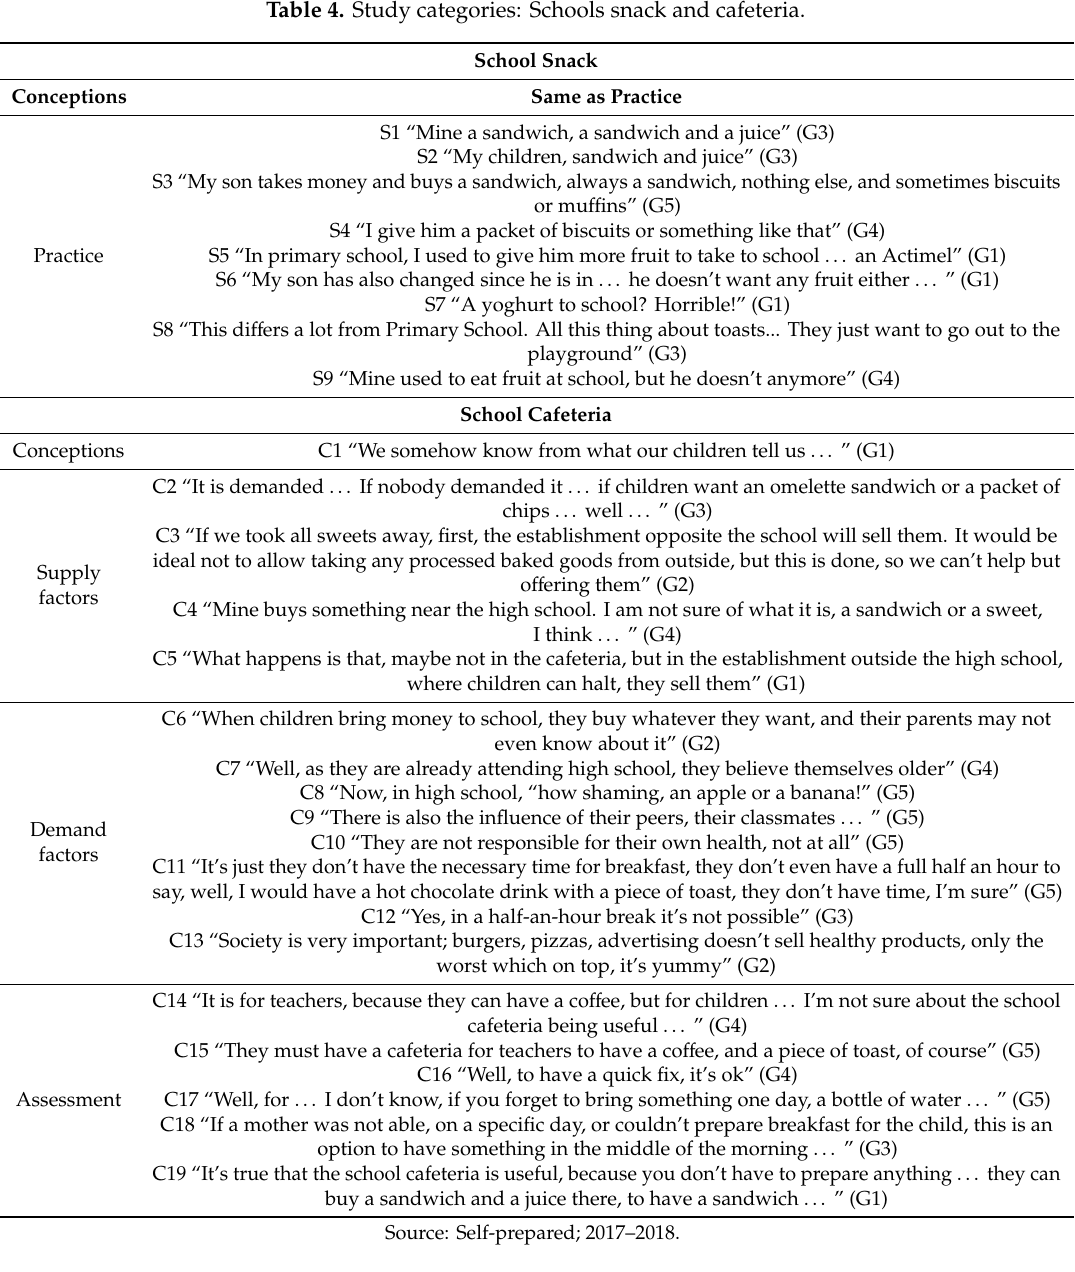
Table 5. Study categories: Measures towards promoting healthy